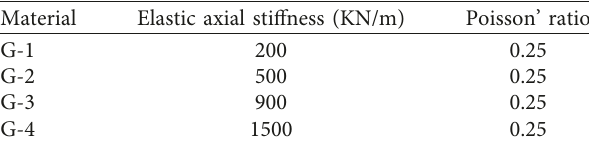
Table 2: Mechanical properties of geogrid